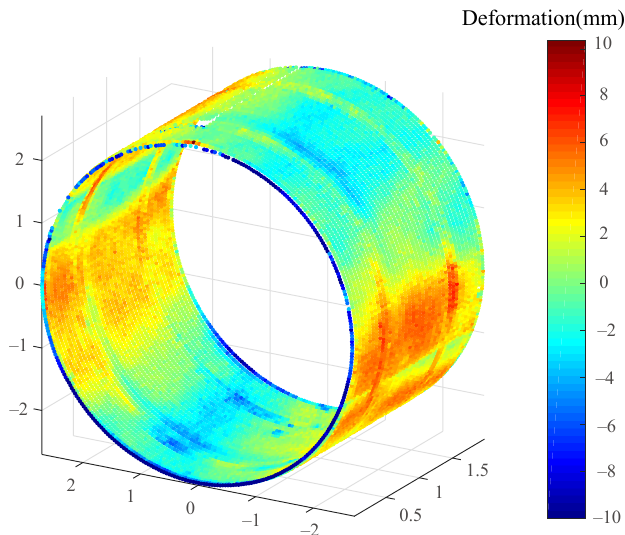
Figure 14. The three-dimensional deformation nephogram of a single tunnel point cloud segment. The different values of deformation are expressed by different colors.